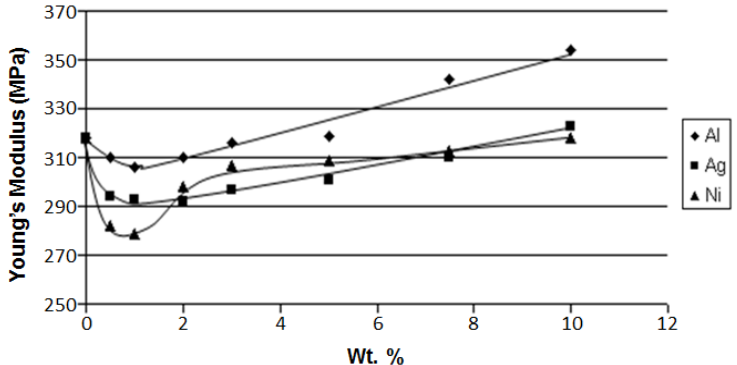
Figure 2. Tensile modulus of Hytrel as a function of the metal micropowder concentration. Reprinted from [10] with permission. Copyright Society of Plastics Engineers, 2008.